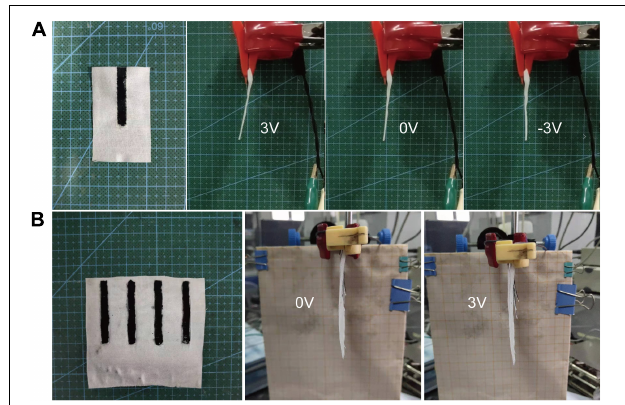
FIGURE 8 | Applications of textile actuators. (A) Small electrode textile actuator work at 0.1 Hz (the fabric area is 10 times that of the electrode). (B) Several parallel devices under the applied voltage of DC 3